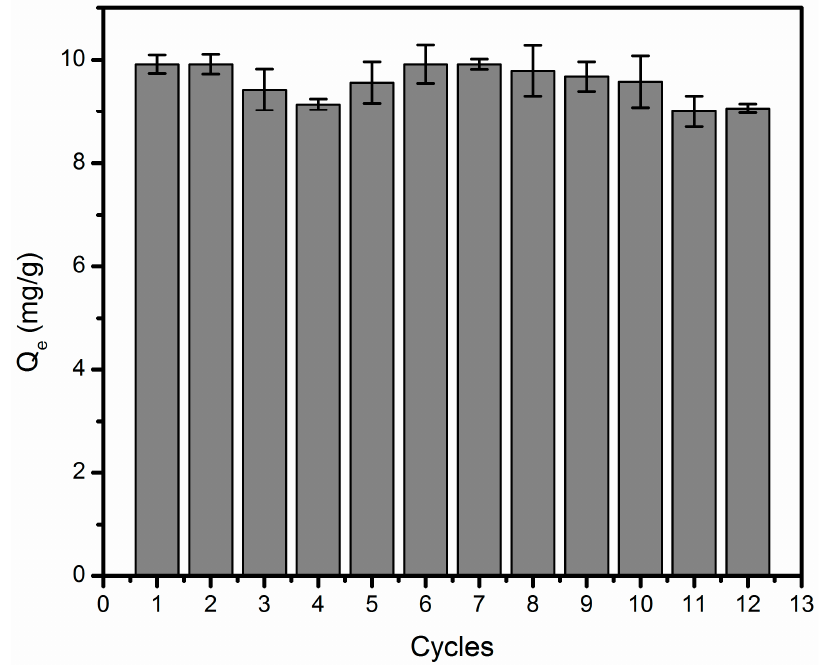
Figure 10. Regeneration performance of Mag-PVP (BPA concentration = 5 mg/L; adsorbent dosage = 0.2 g/L; shaking time = 4 h). Error bars represent standard deviation values from three replicates.